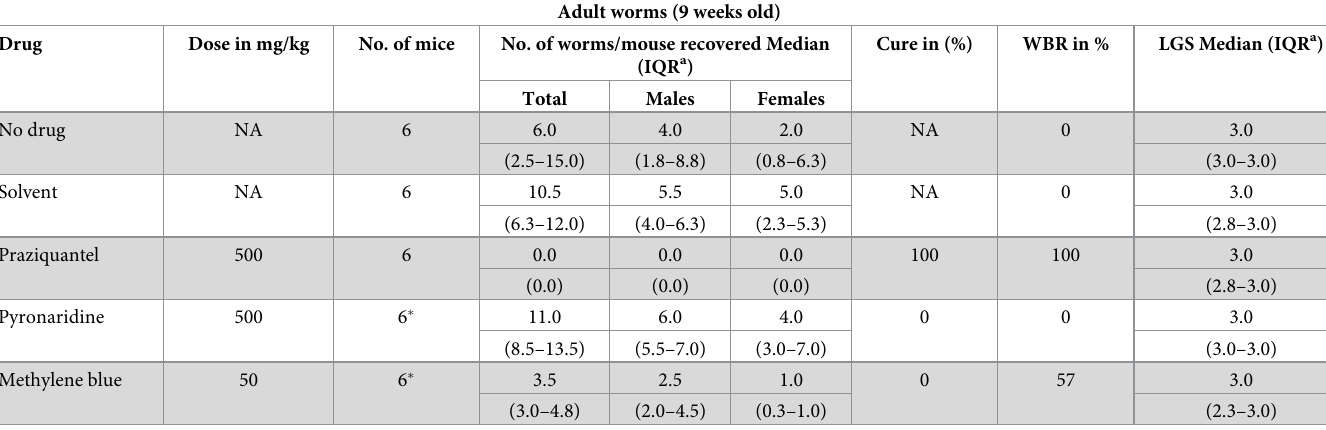
Table 4. Activity against adult S . mansoni in